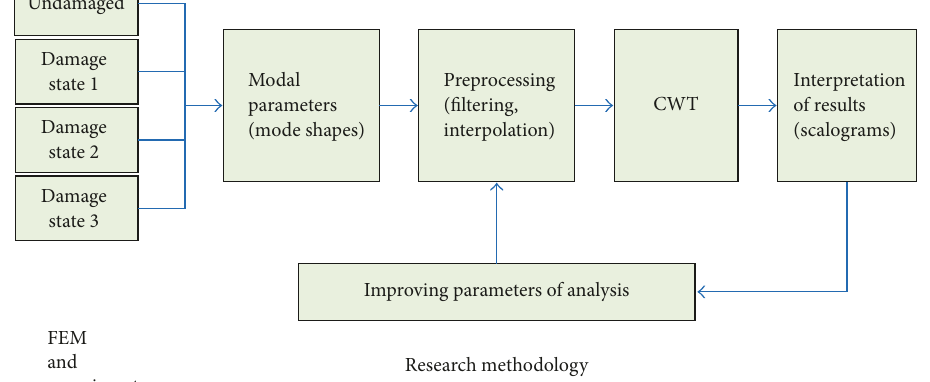
Figure 2: A scheme of detailed research methodology.